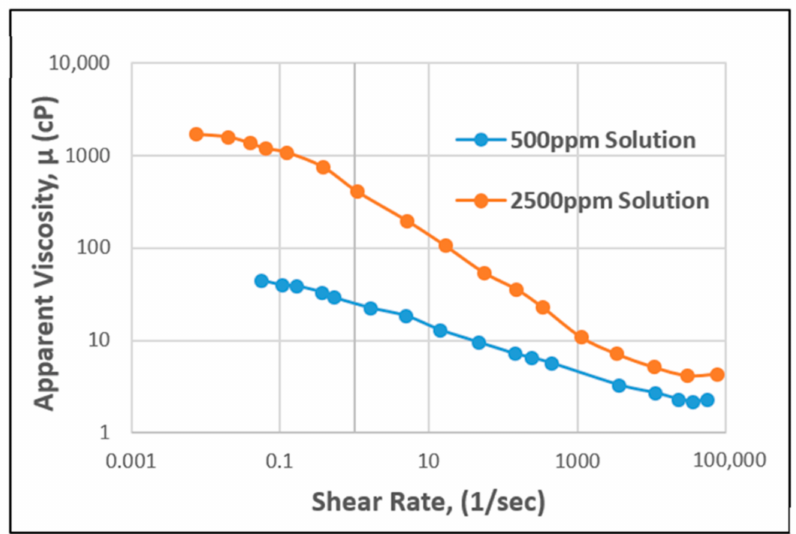
Figure 8. Apparent viscosity vs. shear rate of HPAM. Reprinted and modified from [54].